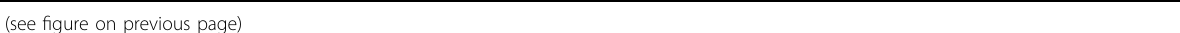
Fig. 3 JmjC-KDMs activity inhibition effect on RT response in ESCC hypoxic cell lines. a Representative images of total protein levels of H3K9me2 (17 kDa), H3K27me3 (17 kDa) with 50 μ M IOX1 JmjC-KDM inhibitor under hypoxic conditions (50 µM CoCl 2 or 0 – 1% O 2 ). β -actin was used as loading control. CoCl 2 + 50 μ M IOX1 and hypoxia + 50 μ M IOX1 were normalized to CoCl 2 and hypoxia alone, respectively. A representative picture of three independent replicates was chosen. b Representative merged staining pictures of KDM3A and KDM6B (green fl uorescence) with H3K9me2 and H3K27me3 (red fl uorescence). All pictures were taken from Olympus IX51 microscope at ×200 magni fi cation (scale bar 50 μ m). c Cell survival curves for 20 μ M IOX1 in combination with irradiation treatment [0 – 8 Gy] under hypoxic conditions (50 µM CoCl 2 and 0 – 1% O 2 ). Results are presented as mean±SD of at least three independent experiments; (*) comparison between 20 μ M IOX1 + hypoxia and hypoxia alone; (#) comparison between 20 μ M IOX1 + 50 µM CoCl 2 and 50 µM CoCl 2 alone; * p < 0.05; ** p < 0.01; *** p < 0.001; p < 0.0001; # p < 0.05; ### p < 0.001. d Effect of combined 50 µM IOX1 + 2 Gy irradiation treatment in DNA damage of ESCC cells for 50 µM CoCl 2 and hypoxia conditions by comet